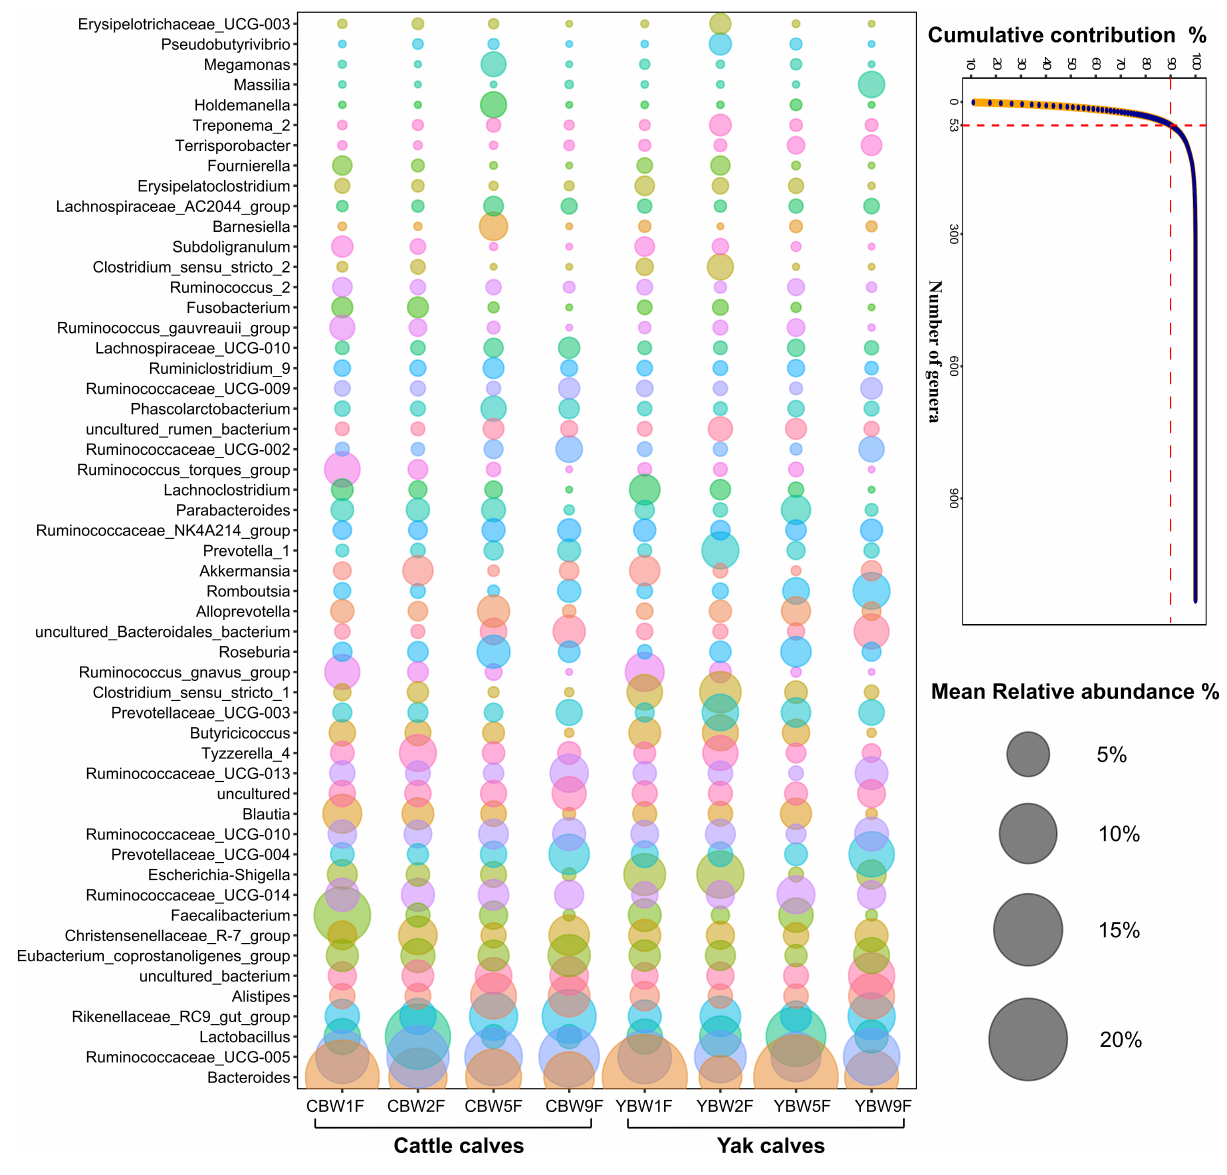
FIGURE 6 | Similarity percentage analysis (SIMPER). The line graph shows the result of the SIMPER analysis performed with the PAST program, where all genera under a defined threshold (90%) of the cumulative contribution are declared as specialized genera. The number of genera indicates the accumulation of types of microbial communities at the genus level. Bubble-plot represents specialized microbial communities in the intestines of yak and cattle calves before weaning, while the size of the bubble represents the relative abundance of the respective